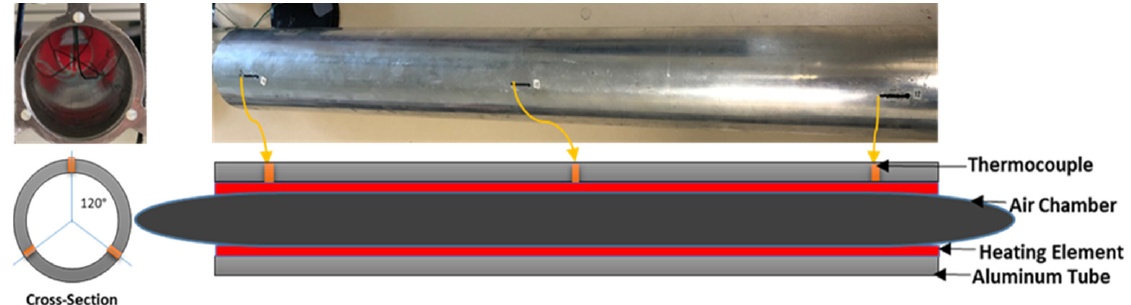
Figure 3. Schematic for the experimental tube.